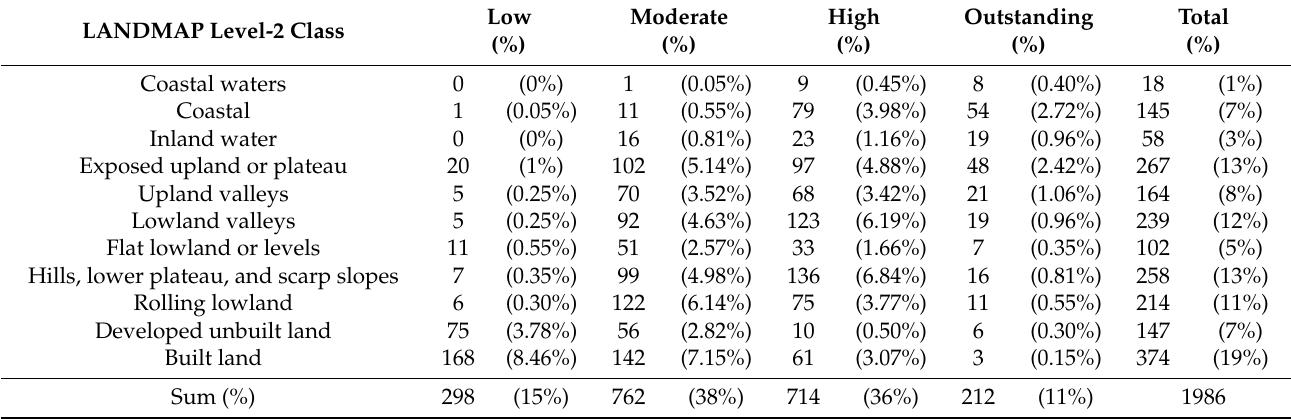
Table 3. Contingency (cross-tabulation) table of the level-2 landscape typologies and the expert-evaluated scenic quality. A total of 1991 aspect areas were classified with 5 unassessed